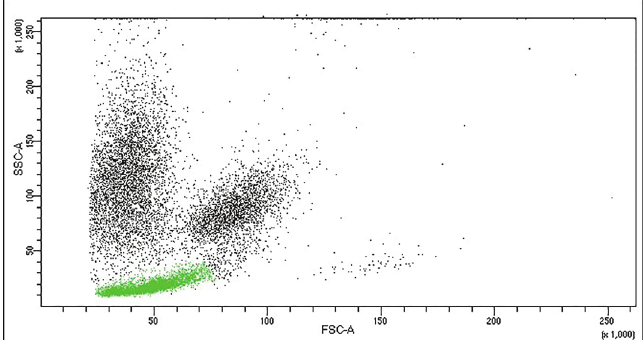
Figure 1 - Representative FSC/SSC dotplot. The region of lymphocytes was gated based on the forward and side scatters. It is highlighted in green.